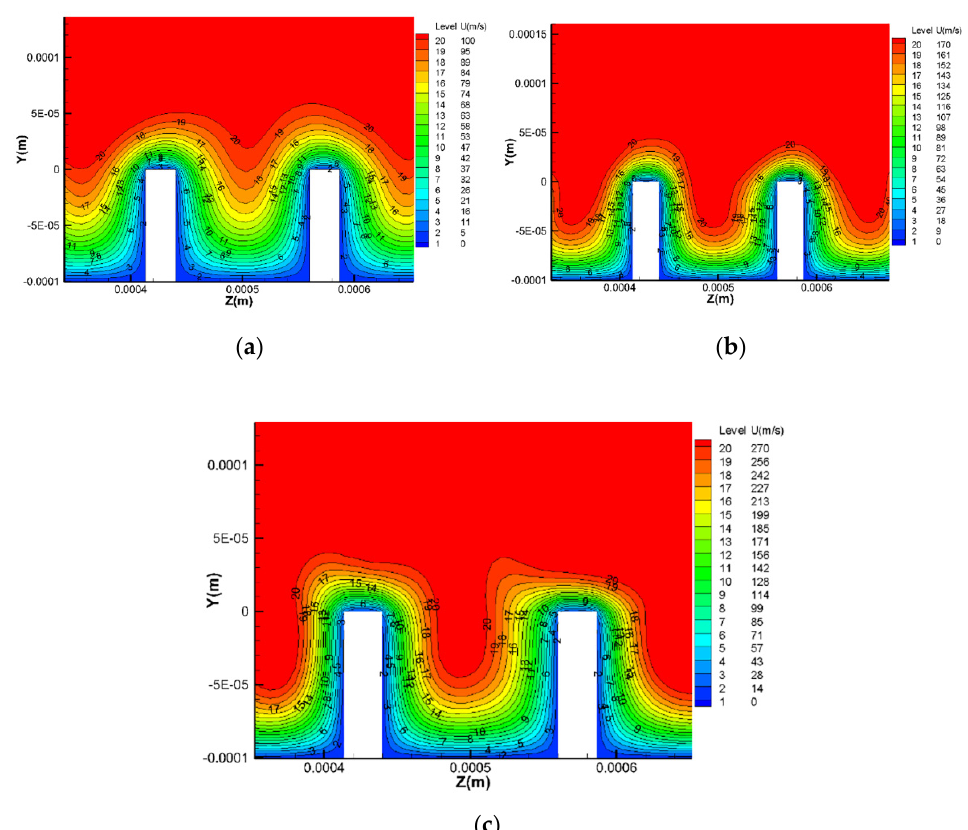
Figure 24. Flow plane velocity cloud of rectangular groove plate under different Mach number; ( a ) 0.3 Ma; ( b ) 0.5 Ma; and ( c ) 0.8 Ma.